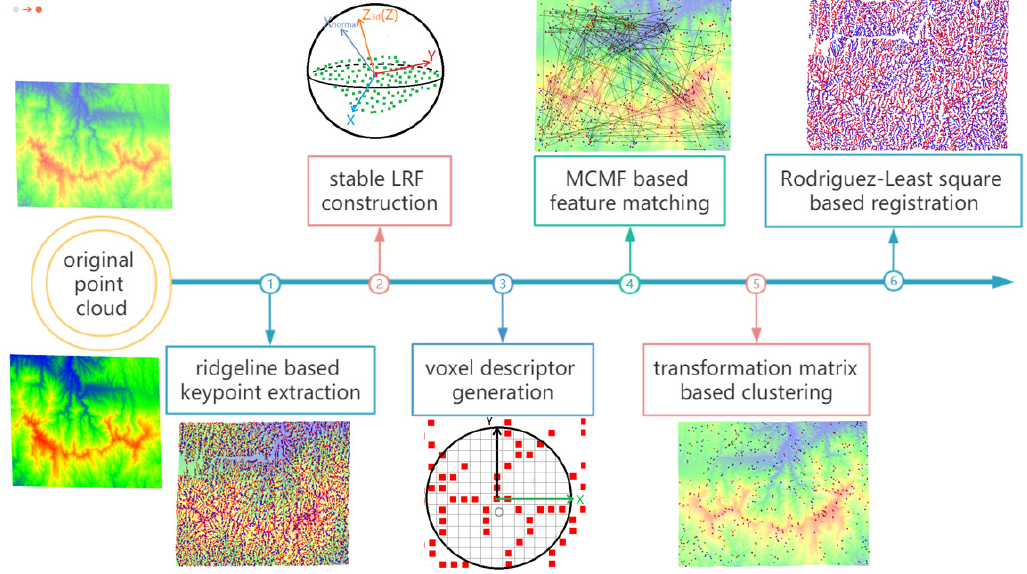
Figure 2. Workflow of the proposed method.